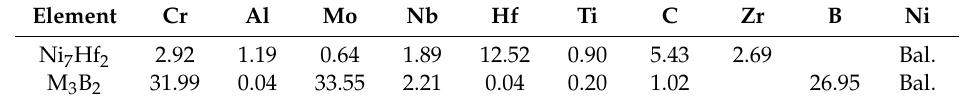
Table 2. EPMA chemical compositions in at % of the solidification products ahead of the liquation cracks indicated in Figure 7c. Element